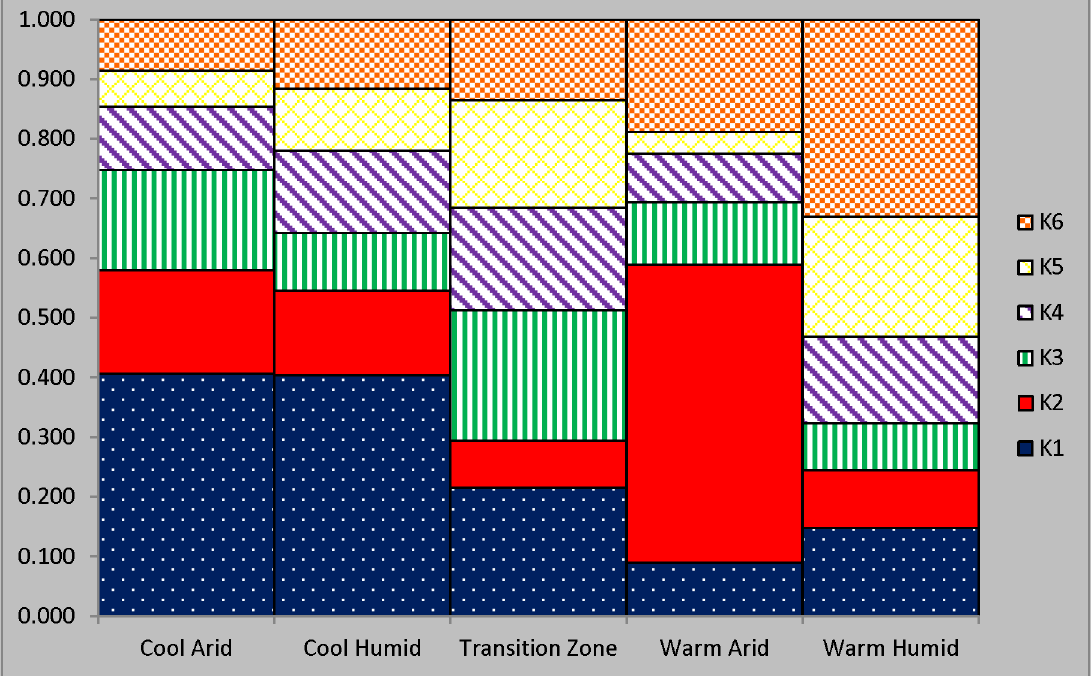
Fig 3. ADMIXTURE assignment of six clusters among the five ecoregions using 14,312 SNP markers.